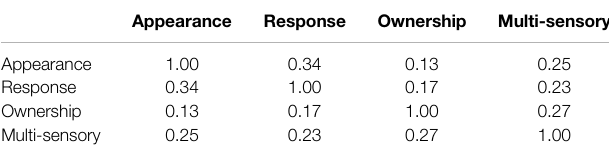
TABLE 4 | Pattern matrix of factor